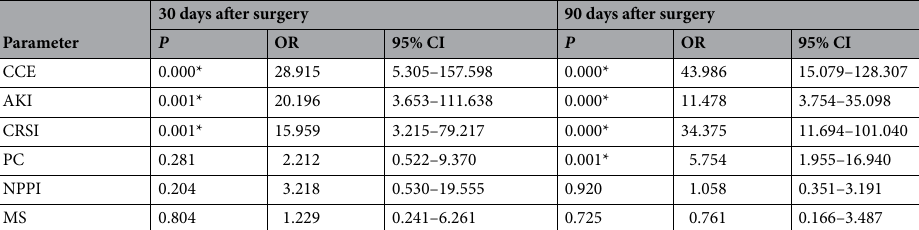
Table 5. Multivariate Cox regression analysis of patients within 30 days or 90 days after surgery. * P value was less than 0.05, with statistical significance. CCE Cardiovascular and cerebrovascular event, AKI Acute kidney injury, CRSI Complications requiring surgical intervention, PC Pulmonary complications, NPPI Non- pulmonary postoperative infection, MS Metabolic